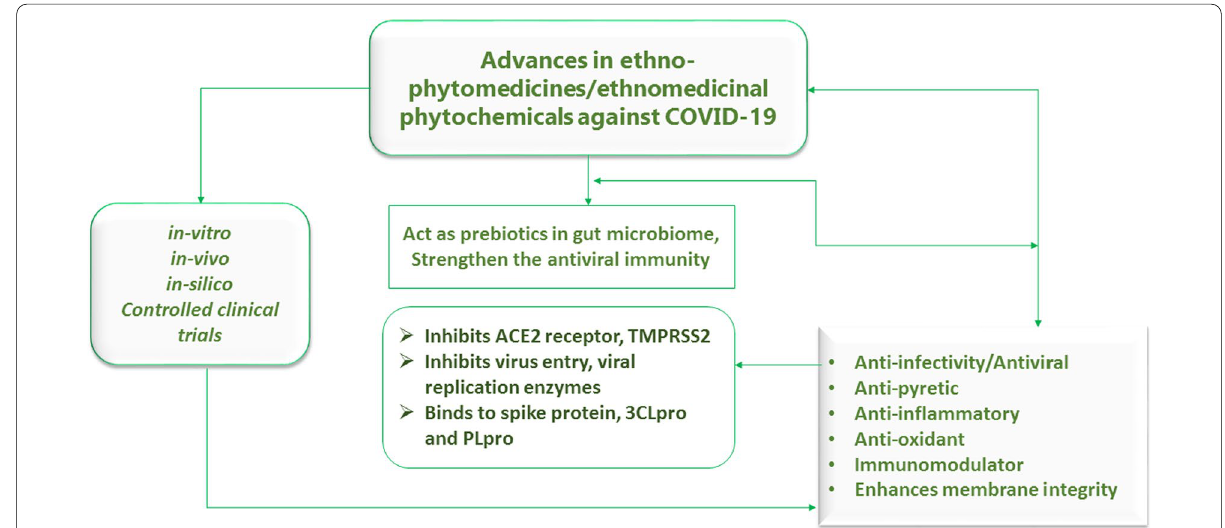
Fig. 3 Summary of advances in ethno-phytomedicinal knowledge in the terms of COVID-19 healthcare